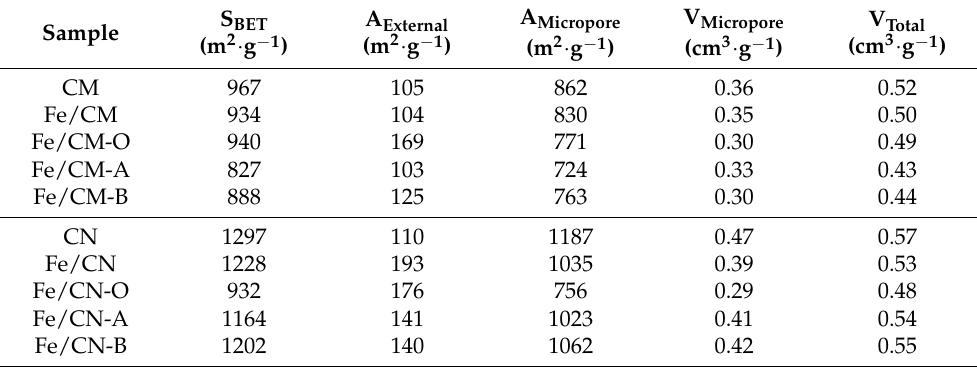
Table 1. Textural characteristics of Fe/AC- f catalysts and corresponding raw AC.